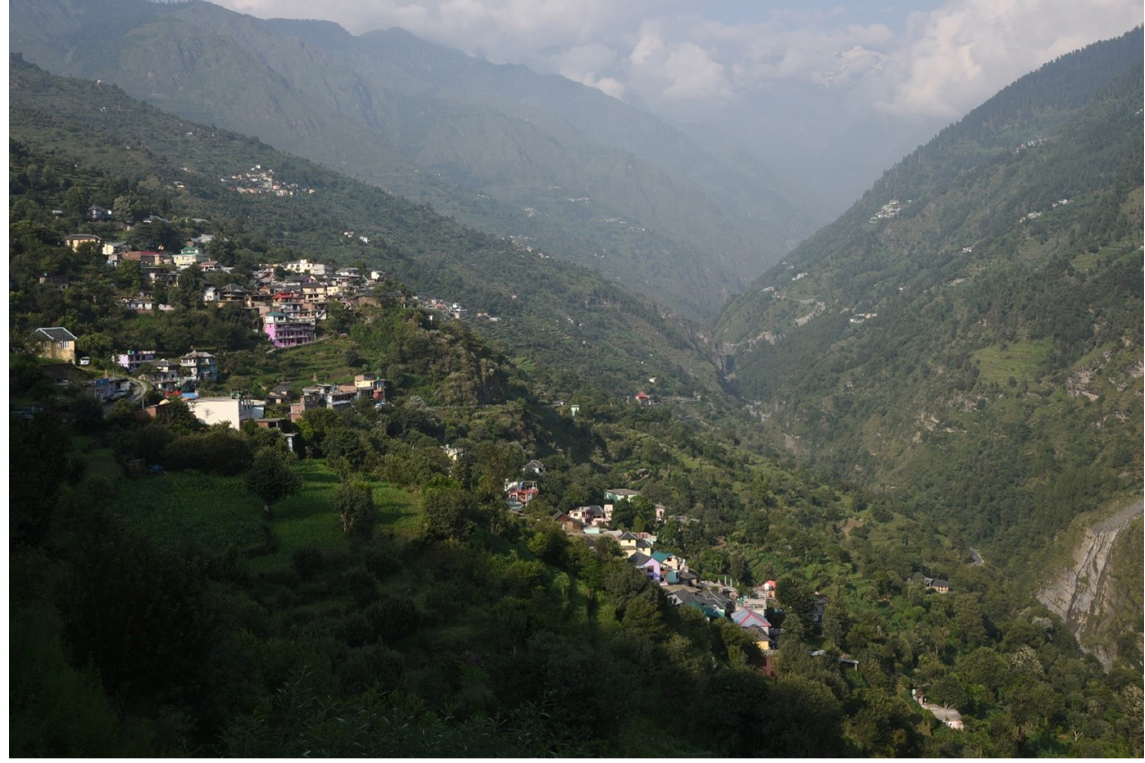
Fig. 9. The habitat of Gloydius chambensis sp. nov. in Chamba District, Himachal Pradesh, India (elevation = 1700 m). Photo by V.